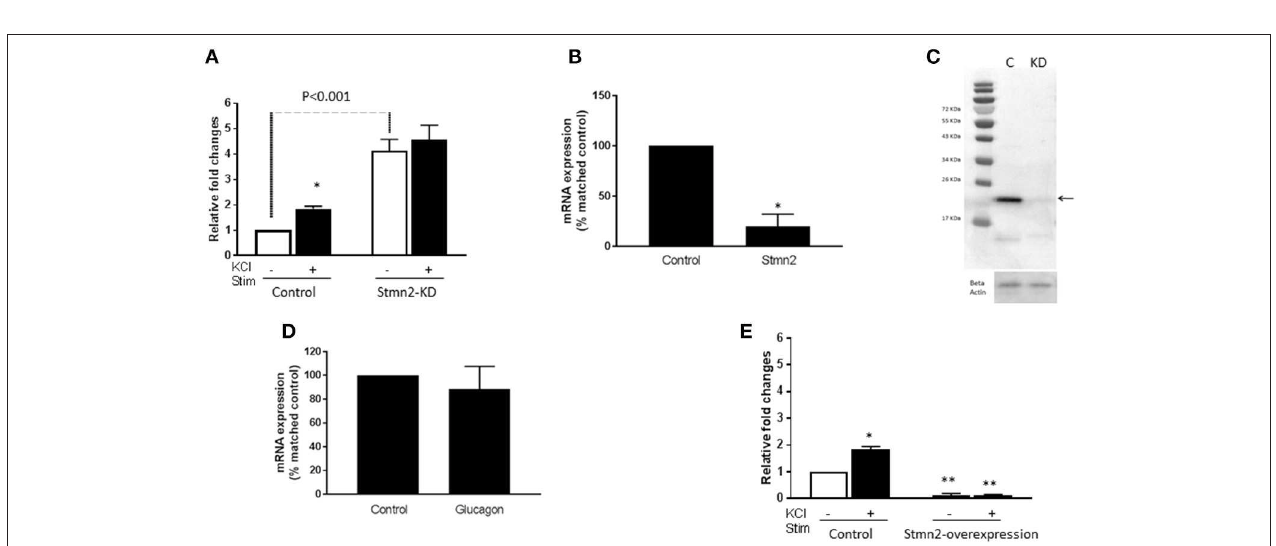
FIGURE 4 | Silencing Stathmin-2 increased glucagon secretion and overexpression of stathmin-2 suppressed glucagon secretion in α TC1-6 cells. Wild type (wt; control) and stathmin-2 depleted (Stmn2-KD) aTC1-6 cells were pre-incubated 2h in serum-free medium and then incubated with or without KCl (55mM) for 15min. (A) Glucagon secretion is significantly stimulated by KCL in wt cells, while in Stmn-KD cells, basal glucagon secretion is increased and does not respond to KCl. * p < 0.01 compared to basal secretion in wt cells. (B) Stmn2 mRNA levels are decreased by about 70% after siRNA-mediated depletion in α TC1-6 cells. Values are means ± SEM ( n = 5), * p < 0.01. (C) Stathmin-2 protein levels are depleted after siRNA-mediated silencing of Stmn2. C (control); KD (gene silenced). Beta-actin was used as a loading control. (D) Proglucagon mRNA levels are not affected by siRNA-mediated depletion of stathmin-2. (E) Glucagon secretion is inhibited by overexpression of Stmn2. α TC1-6 cells were transfected with pcDNA3.1 ( + ) MAr-stmn2 or empty vector (negative control). Both basal and K + -stimulated glucagon secretion were inhibited by overexpression of Stmn2. Values are means ± SEM ( n = 4). * p < 0.05; ** p < 0.001 compared to unstimulated